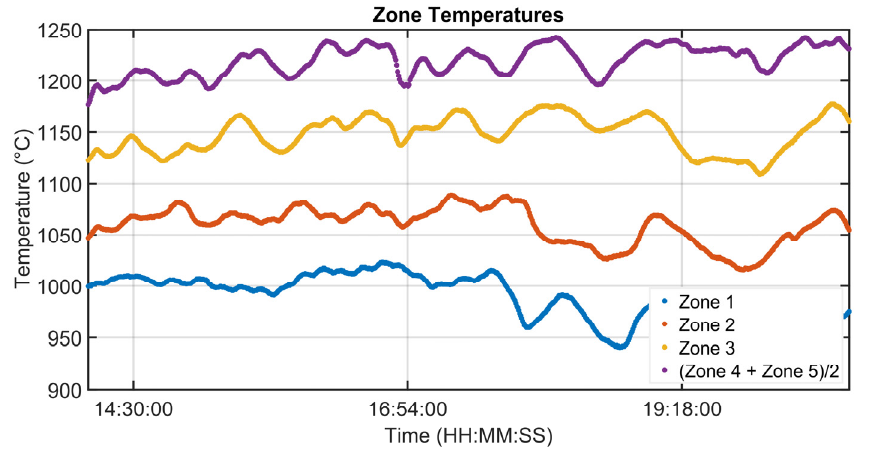
Figure 5. Modelization results: billets temperature model.